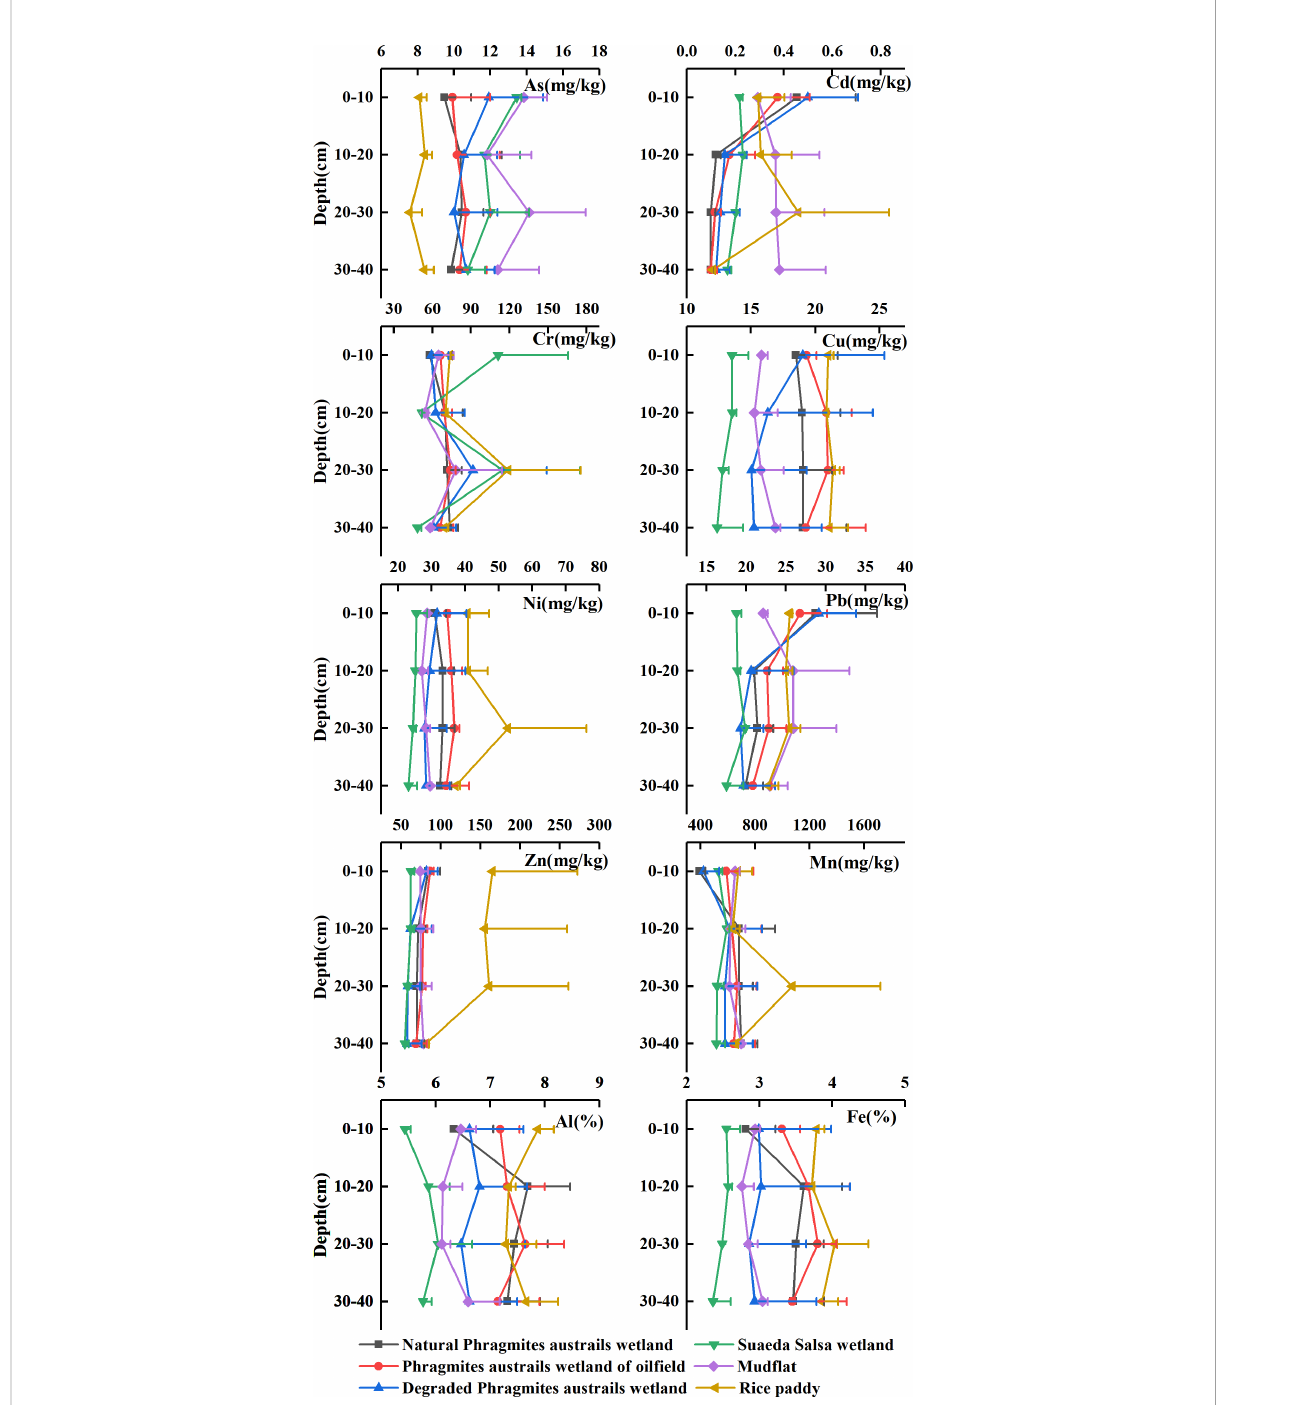
FIGURE 3 Metal distributions in different depths under the six wetland types for Liaohe Delta. Bars indicate the standard